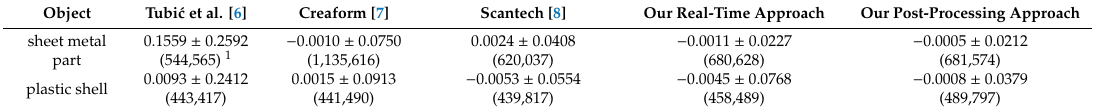
Table 3. C2M error statistics (mean ± Std.) of di ff erent methods in millimeters.